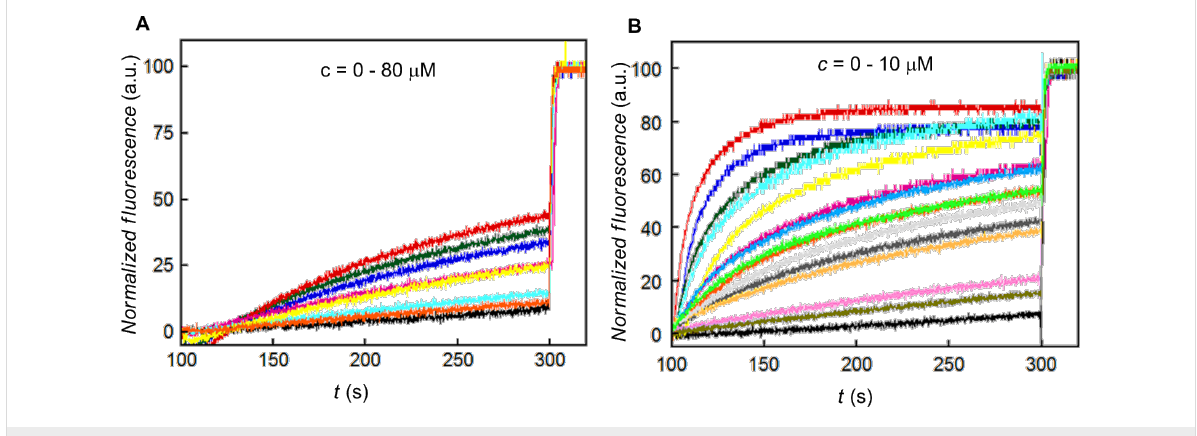
Figure 6: Ion transport activity (A) for 1 , (B) for 2a , across EYPC-LUVs